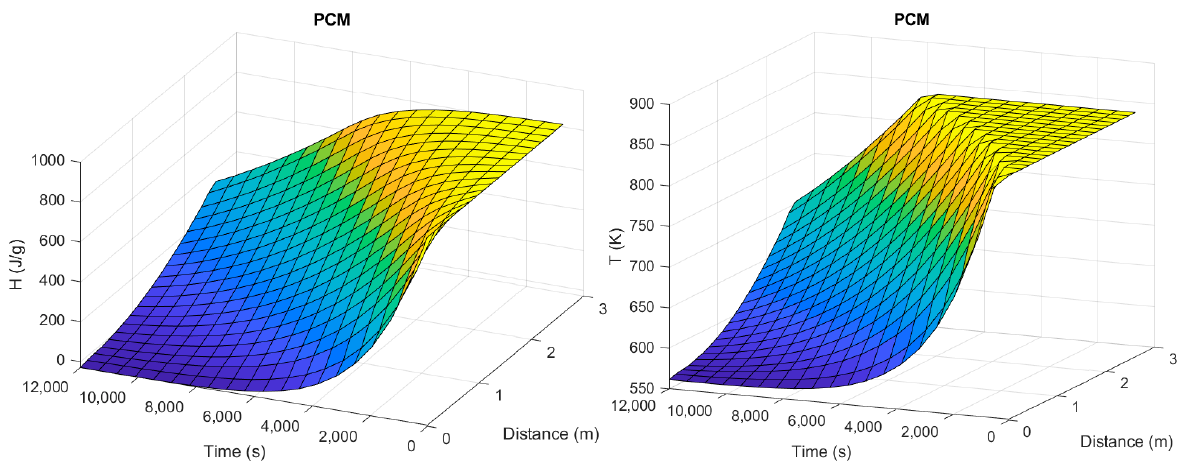
Figure 7. Surface plots of the heat exchanger fluid-dynamic simulation results: HTF temperature (a), PCM enthalpy (b) and PCM temperature (c) as a function of discharging time and heat exchanger height.